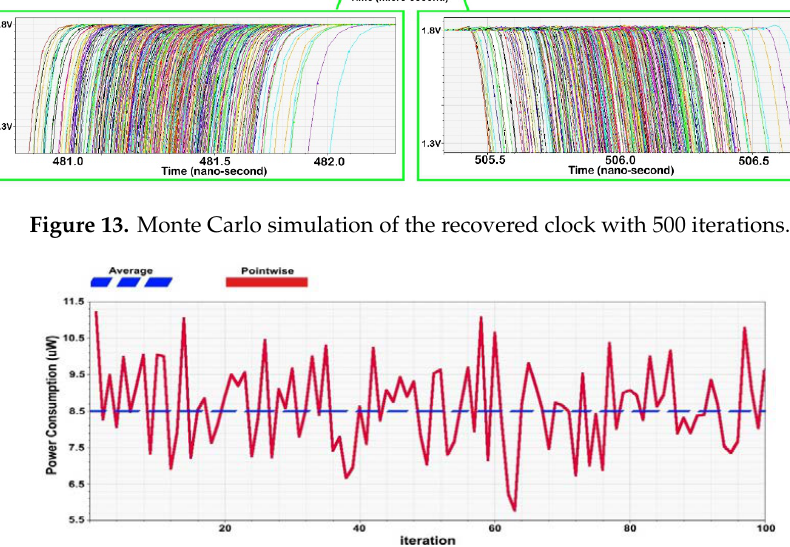
Figure 14. Monte Carlo simulation of power consumption with 100 iterations.